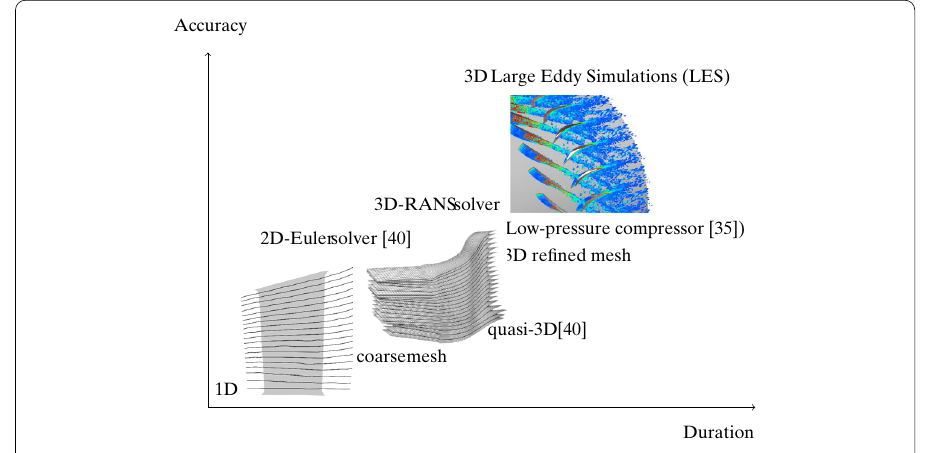
Fig. 1 Illustration of the trade-off between duration and accuracy for different computational fluid dynamics (CFD)